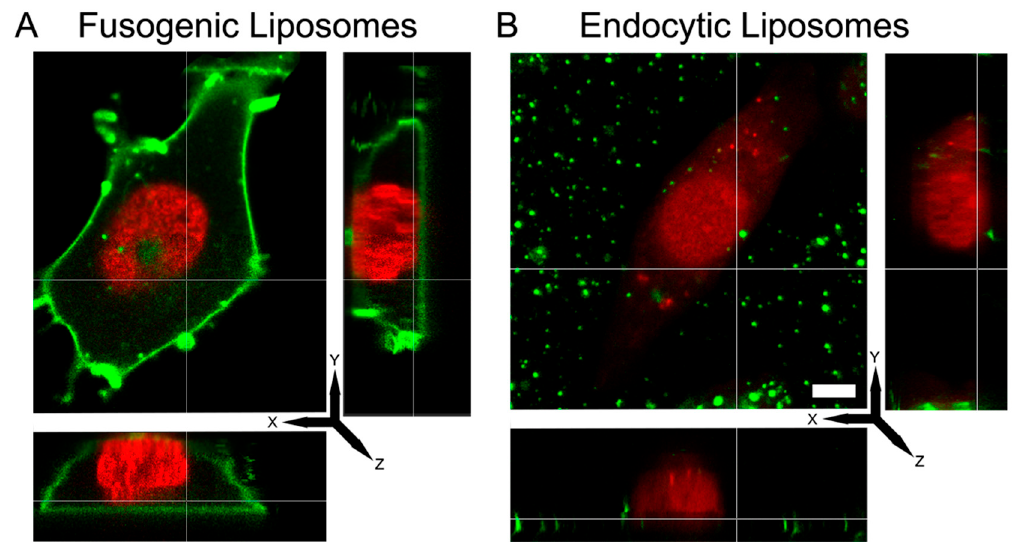
Figure 1. 3D-fluorescence micrograph of a Chinese hamster ovary (CHO) cell treated with fusogenic liposomes (FLs) DOPE/DOTAP/TFPE-head (1/1/0.1 mol/mol) ( A ), and endocytic liposomes (ELs) DOPC/DOTAP/TFPE-head (1/1/0.1 mol/mol) ( B ). Green: TFPE-head signal, red: Nuclei staining with DRAQ5. Scale bar, 20 µm, applies to all.